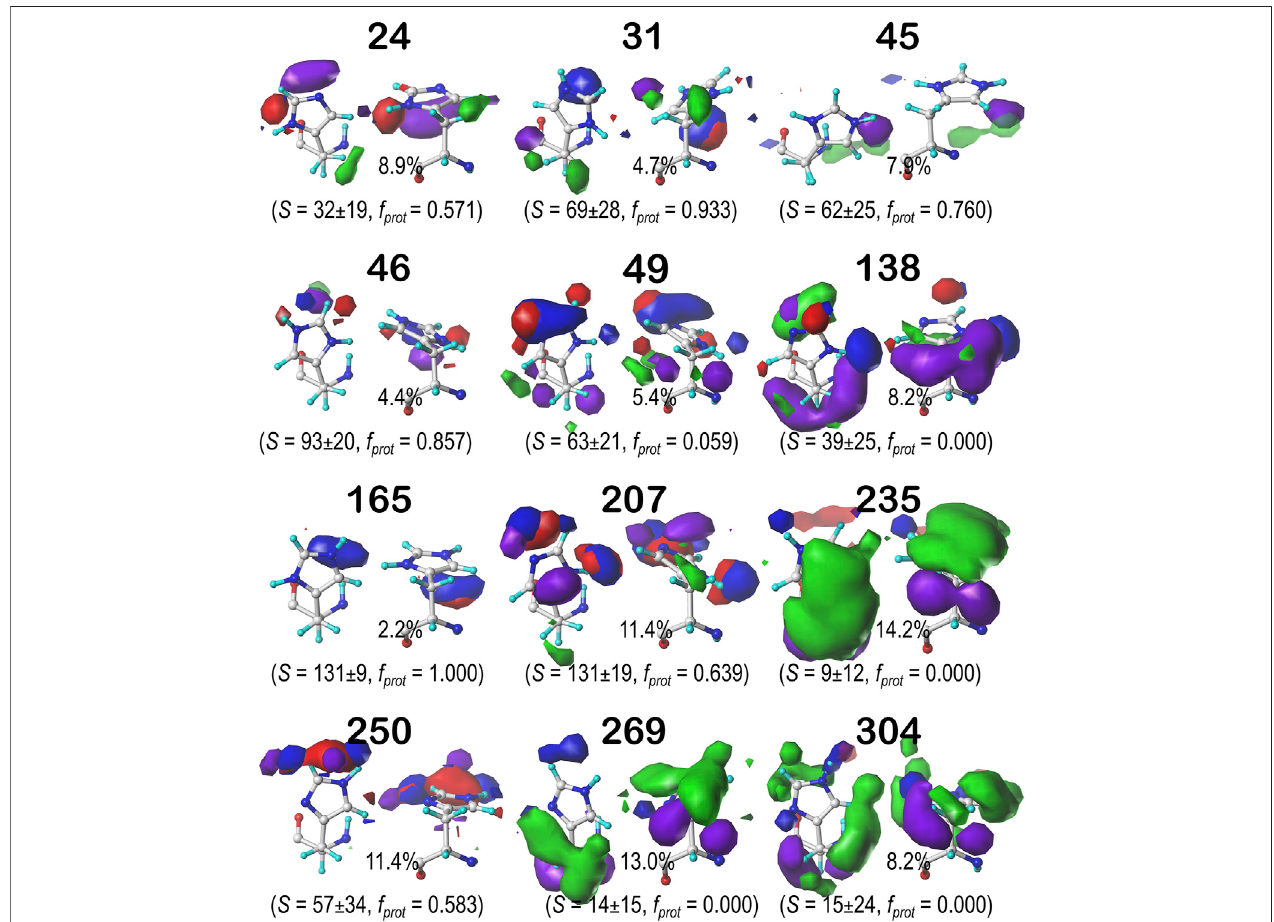
FIGURE 11 | Hydropathic interaction maps displaying the Gaussian-weighted average sidechain environments of histidine in the χ 1 (cid:1) 60 ° parse of the b1 chess square at pH (cid:1) 5.174. See caption for Figure 7 .